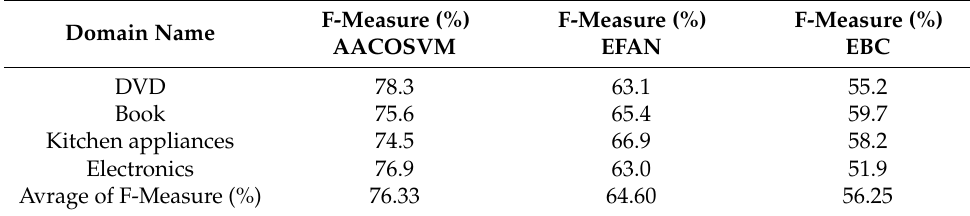
Table 2. Comparative Analysis of F-Measure.